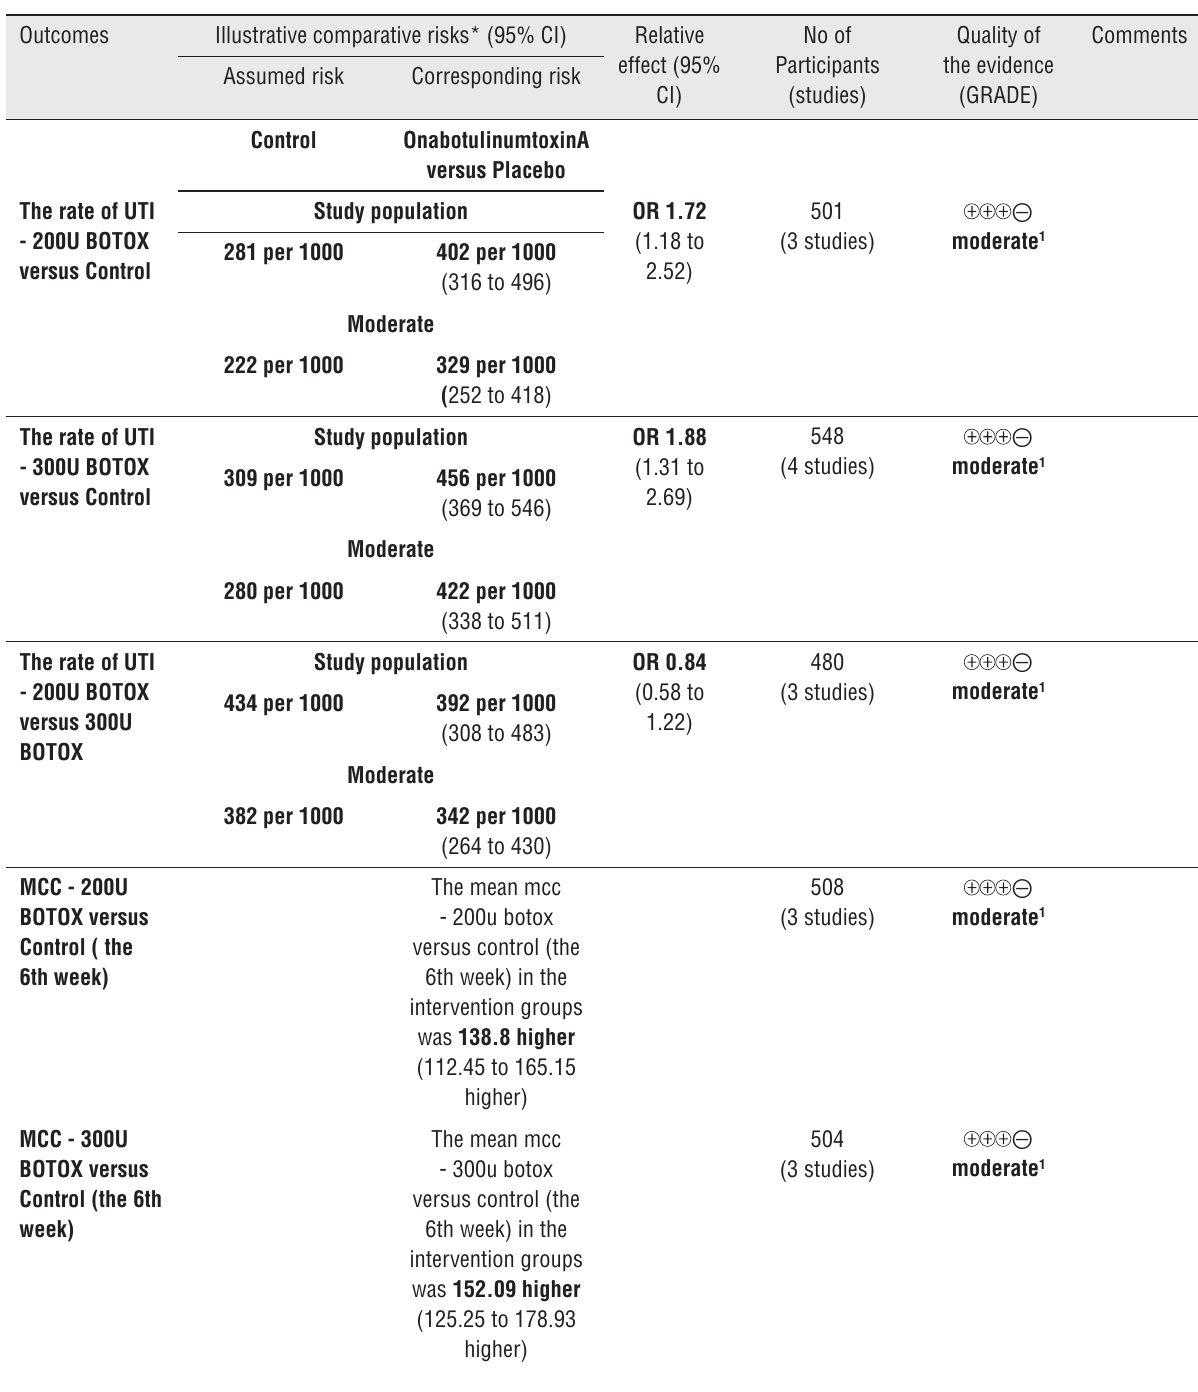
Table 3 - Summary of findings for the main comparisons OnabotulinumtoxinA versus Placebo for NDO Patient or population: patients with NDO Settings : Intervention: OnabotulinumtoxinA versus